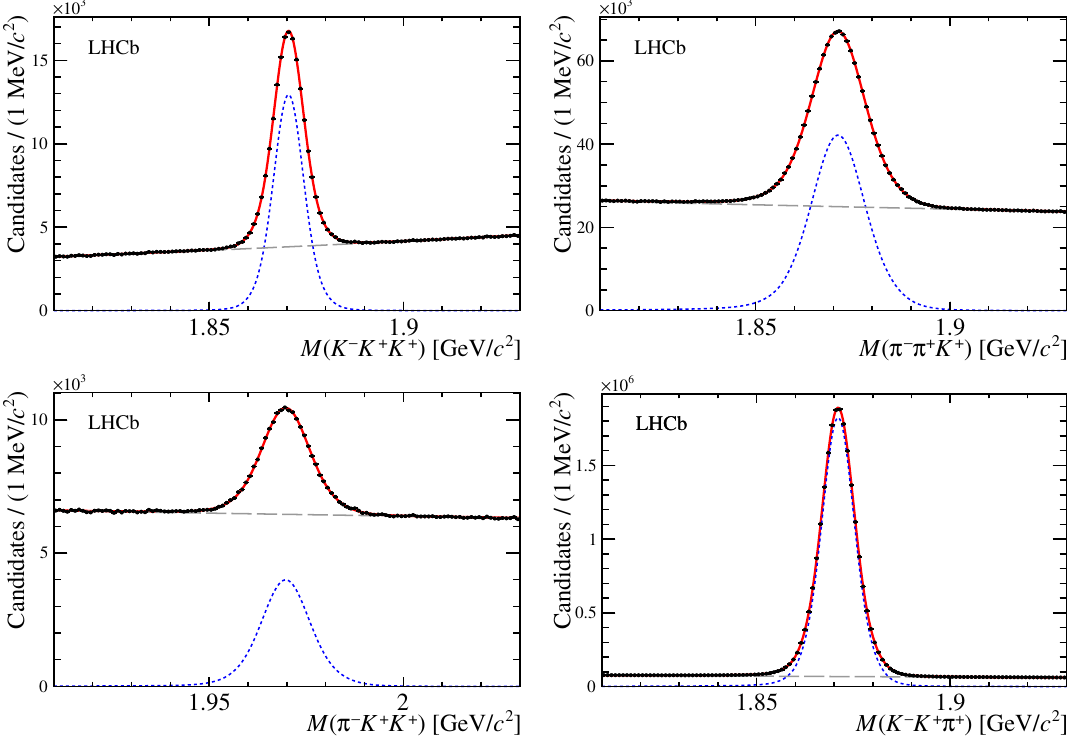
Figure 3 . Invariant-mass distributions of (top left) D + ! K (cid:0) K + K + , (top right) D + ! (cid:25) (cid:0) (cid:25) + K + , (bottom left) D + ! (cid:25) (cid:0) K + K + and (bottom right) D + ! K (cid:0) K + (cid:25) + with the corresponding (cid:12)t s result superimposed (red solid line). The blue dotted line corresponds to the signal PDF and the dashed grey line shows the background PDF.